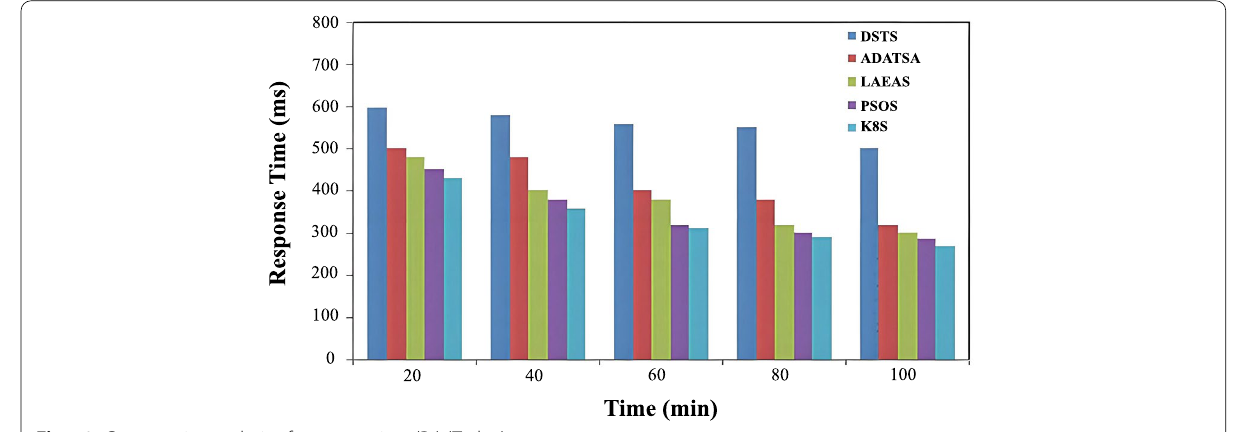
Fig. 12 Comparative analysis of response time (R T ) (Task-5)